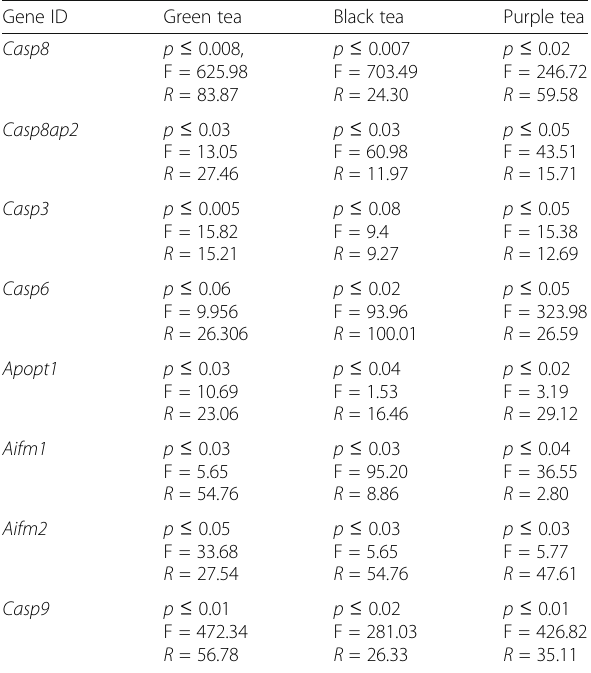
Table 3 Transcriptome analysis of genes affected by green, black and purples teas Gene ID Green